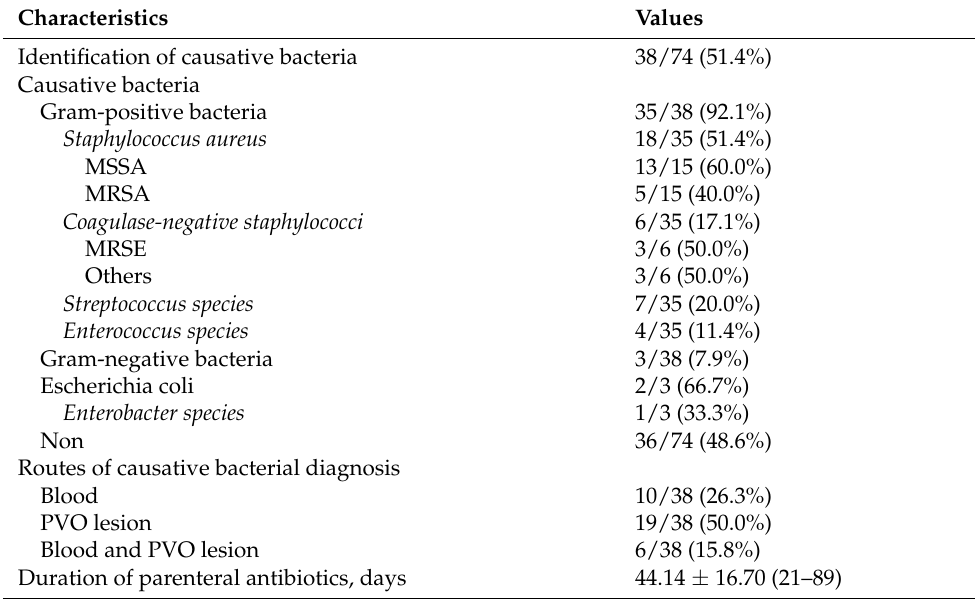
Table 2. Microorganisms and antibiotics.